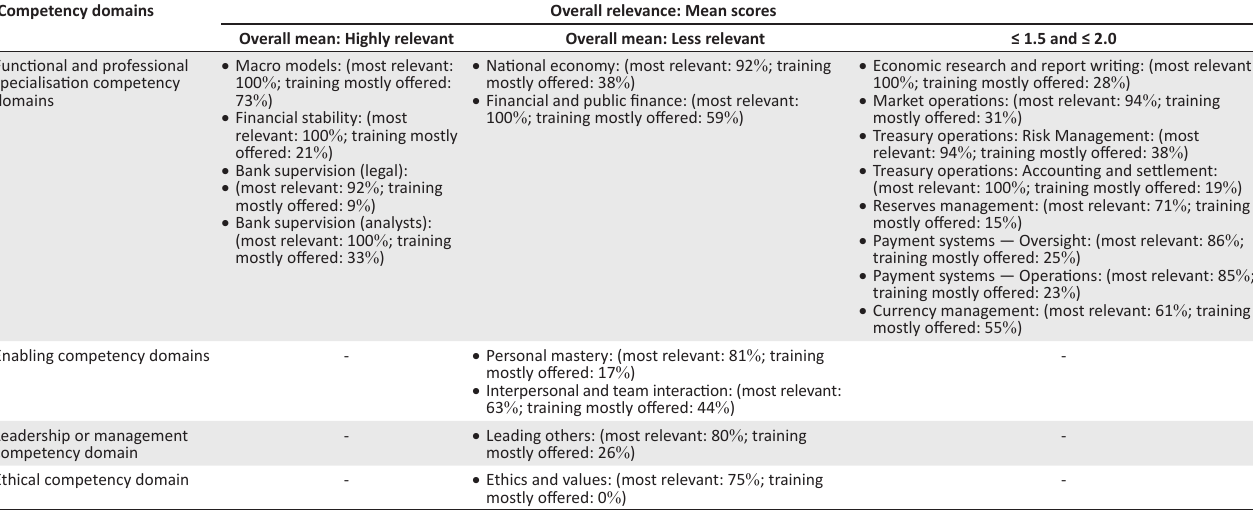
TABLE 6: Quantitatively validated global central banker competency model: Relevant competency clusters and training